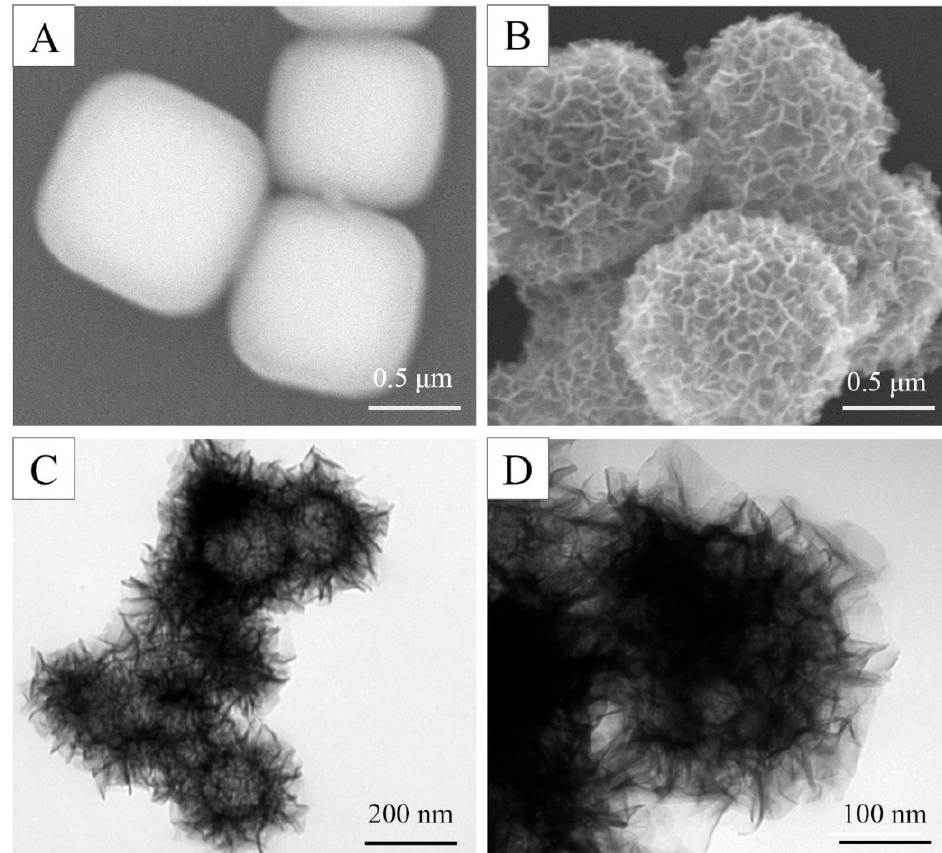
Figure 5. Electron microscopic images of ( A ) hollow SiO 2 under SEM; ( B ) hierarchical hollow SiO 2 @MnO 2 under SEM; ( C ) hierarchical hollow SiO 2 @MnO 2 at low magnification under TEM; ( D ) hierarchical hollow SiO 2 @MnO 2 at high magnification under TEM. Reproduced with permission from [43], ©2021 Elsevier B.V.